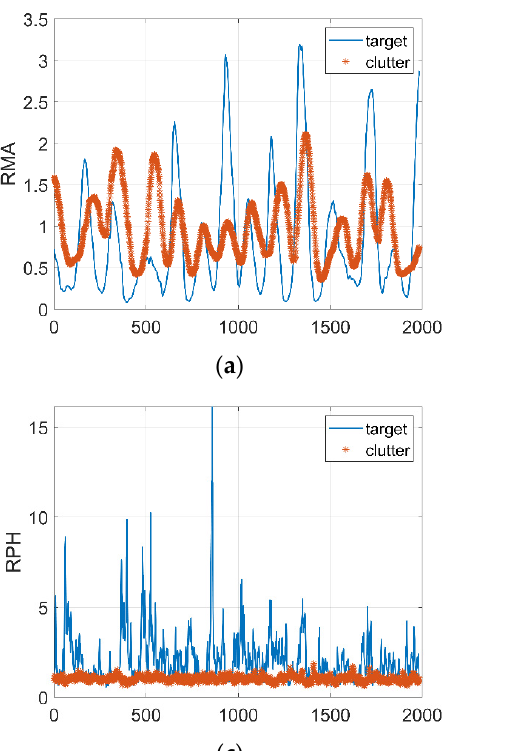
Figure 10. Representation of one-dimensional characteristics on targets and clutter. ( a ) RMA; ( b ) RIET; ( c ) RPH; ( d ) RIED.